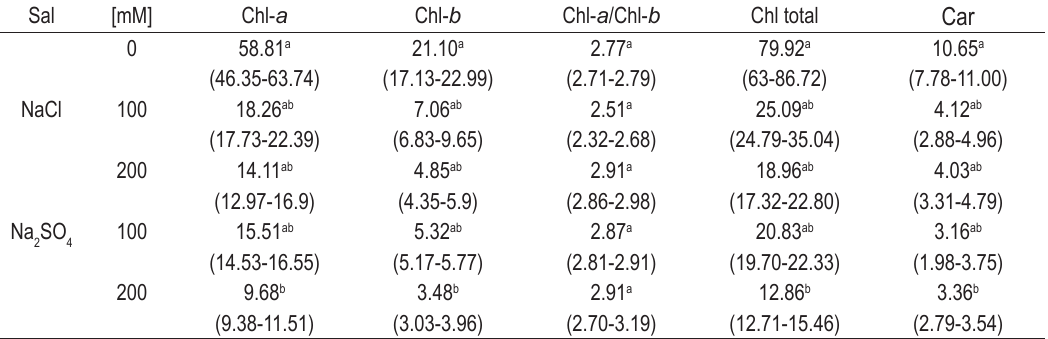
Table 2. Changes in chlorophyll- a (Chlo- a ) and chlorophyll- b (Chl- b ) concentrations, rates of chlorophyll- a and b (Chlo- a /Chlo- b ), and carotenoids (Car) (mg.g –1 DW) in the aquatic fern Salvinia auriculata subjected to salt stress induced by NaCl and Na SO salts. In parentheses are the minimum and maximum values. The small letters refer 2 4 to statistical difference between the control and all saline treatments.